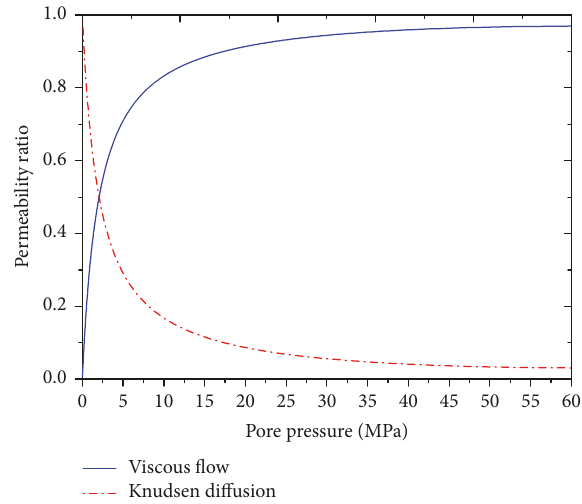
Figure 3: Comparison of the model results with the experimental data of Mathur et al. [36]. The solid and dashed lines are calculated from (10). The parameter set is presented in Table 1.